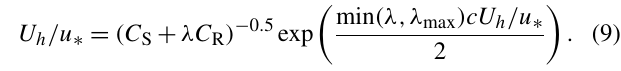
z 0 , v /h top are depicted as orange lines in the left column